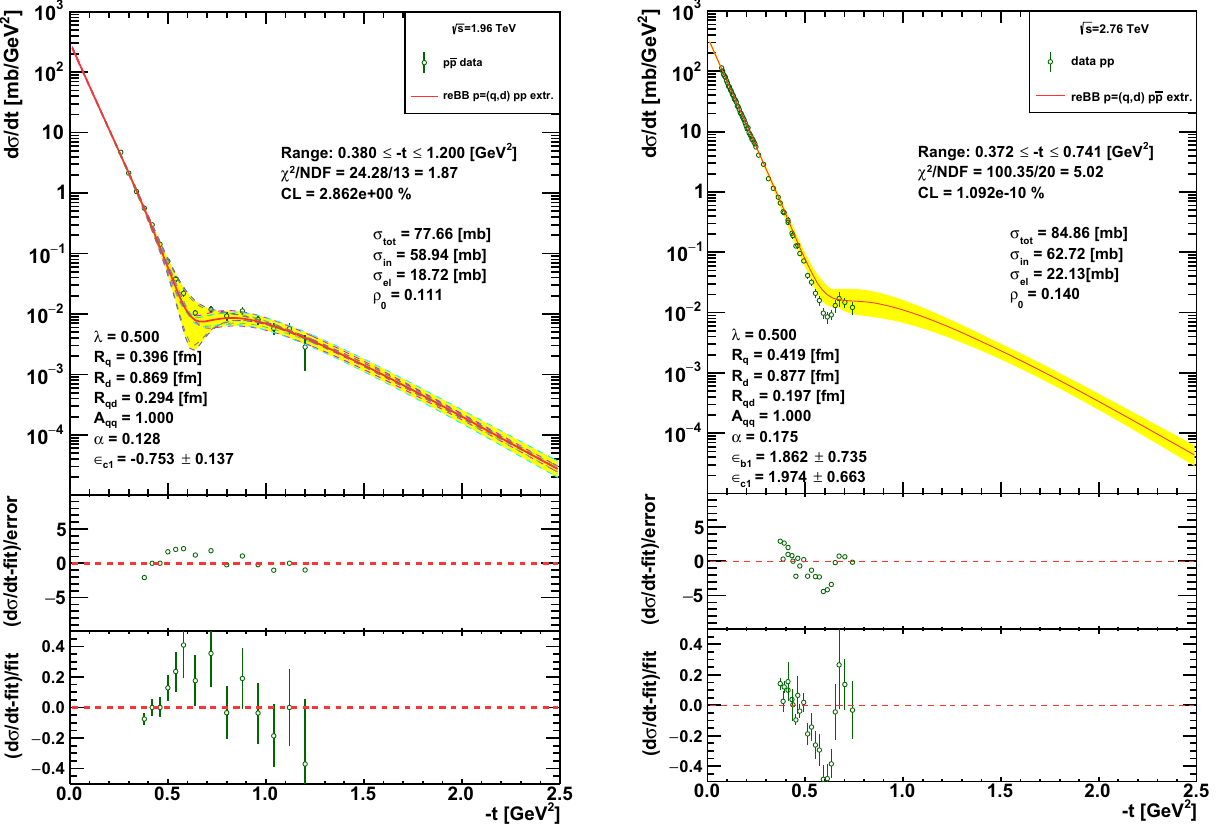
Fig. 16 The ReBB model extrapolation for the pp d σ/ dt at 1 . 96 TeV compared to the p ¯ p D0 d σ/ dt data [45] measured at the same energy. The yellow band is the uncertainty of the extrapolation. The calculated CL value between the extrapolated model and the measured data does not indicate a significant difference between the pp and p ¯ p differential cross sections